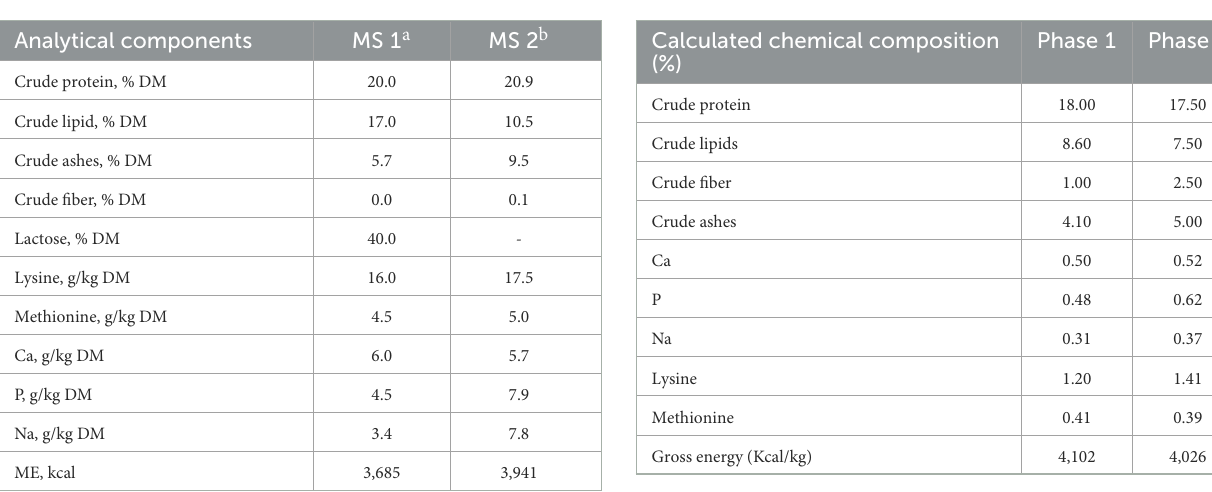
TABLE 2 Milk supplements composition. TABLE 3 Creep feed